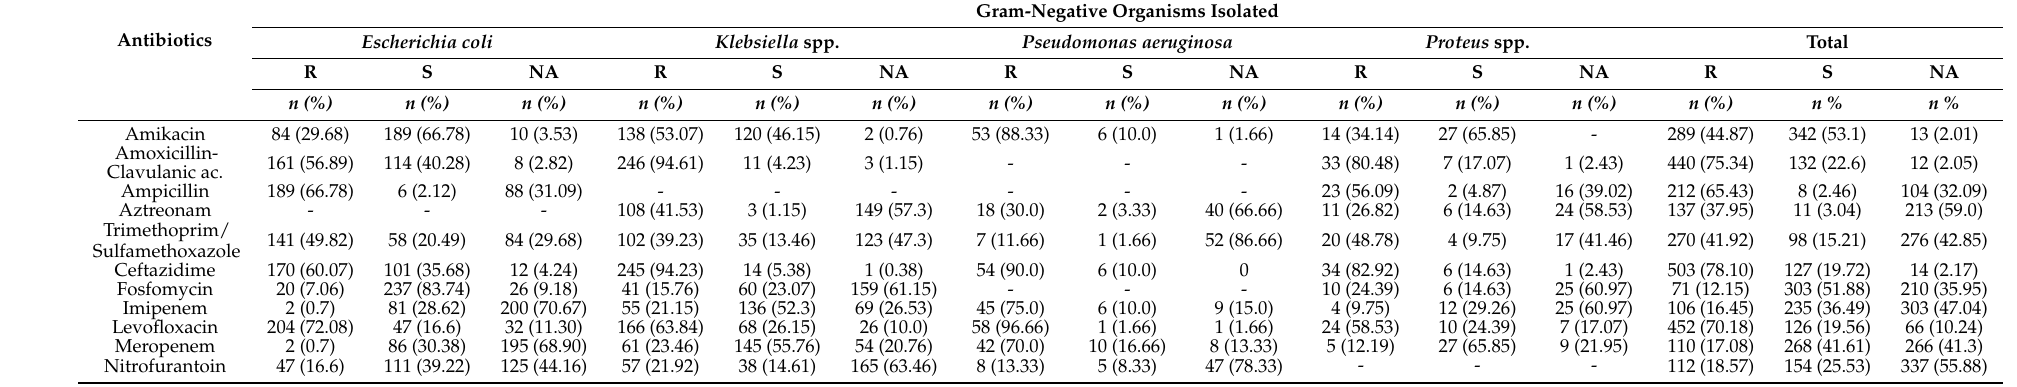
Table 3. Gram-negative uropathogen resistance